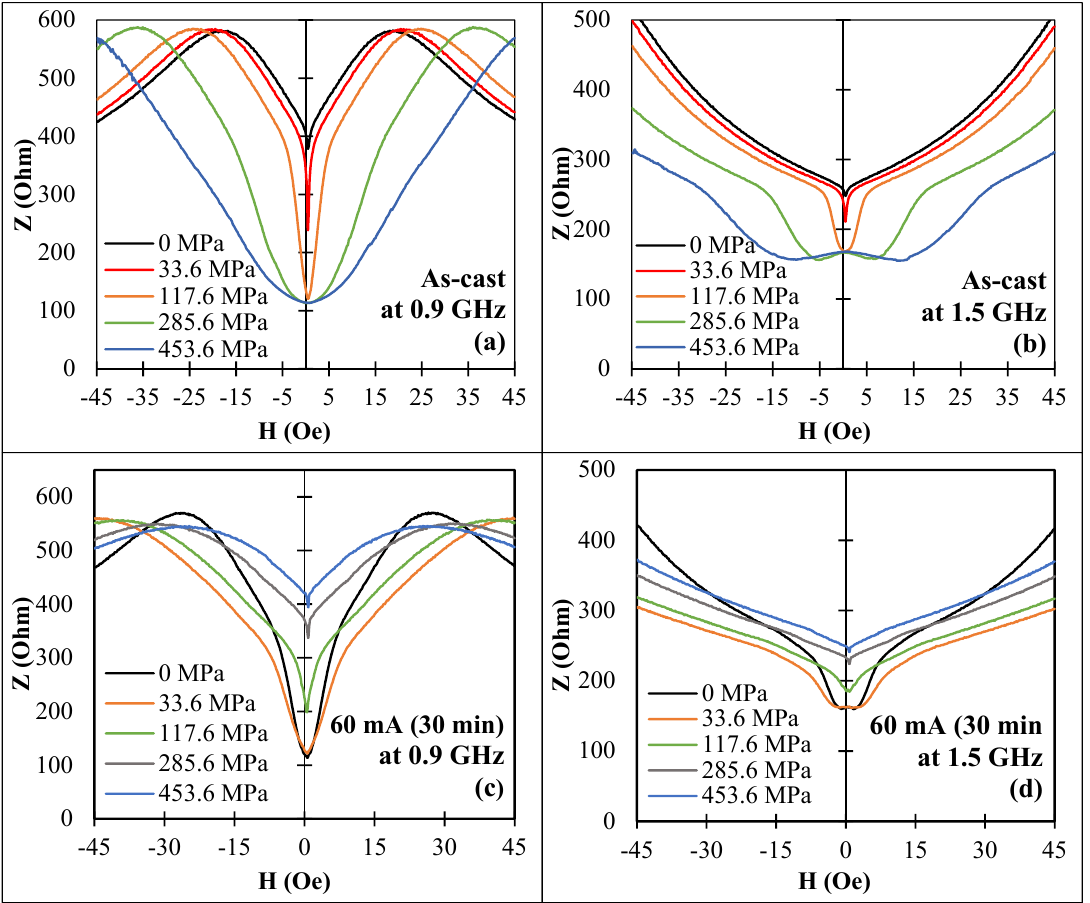
Figure 12. Effect of a tensile stress on MI vs. magnetic field for amorphous Co 71 Fe 5 B 11 Si 10 Cr 3 microwires (sample No2) in as-cast state in ( a , b ) and after current annealing (60 mA, 30 min) in ( c , d ) for different frequencies: ( a , c ) − 0.9 GHz; ( b , d ) − 1.5 GHz. Z corresponds to the impedance amplitude.